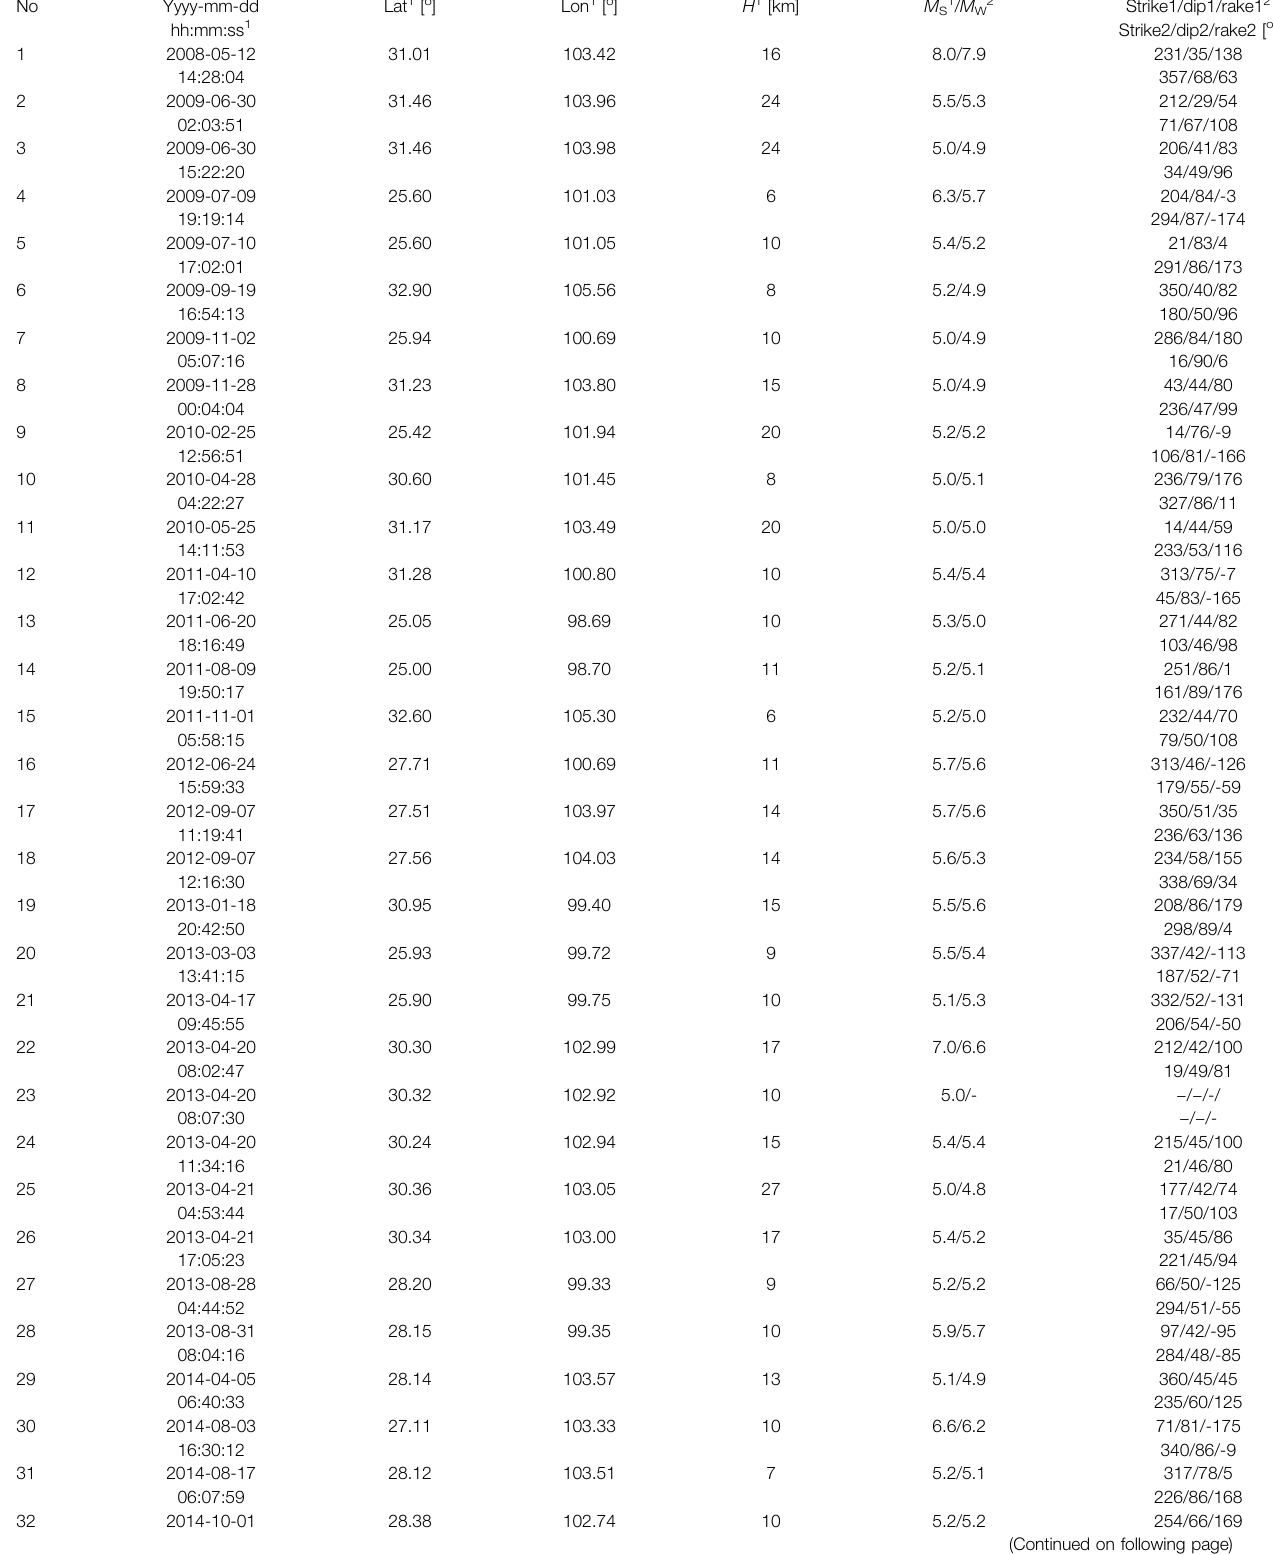
TABLE1| Sourceparametersofthe2008Wenchuan M S 8.0and57 M S ≥ 5.0earthquakes(2009-01-01 – 2019-08-04)inthestudyregion(98.5 o E – 106.0 o E,22.0 o N – 34.0 o N) from China Earthquake Networks Center (CENC) and the Global Centroid-Moment-Tensor